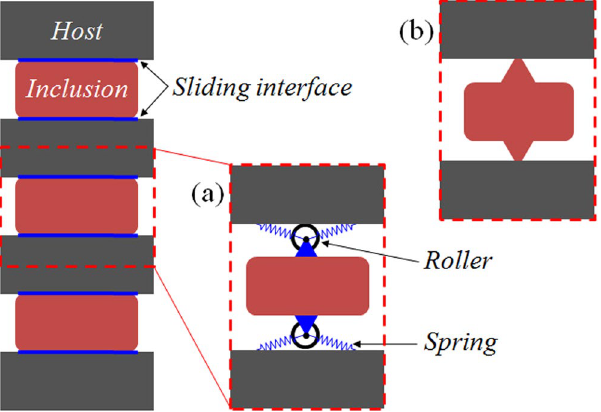
Figure 1. Conceptual models of solids with broadband anisotropic mass. ( a ) A layered solid-solid structure with the sliding interfaces and one of phases constitutes the host, wherein a moderate interface stiffness, denoted by the spring, needs to be added in order for the mechanical stability. ( b ) A realistic structural material that is designed according to the model in ( a ) where the spring-reinforced sliding interface is practically realized by the slender geometric connection between layered